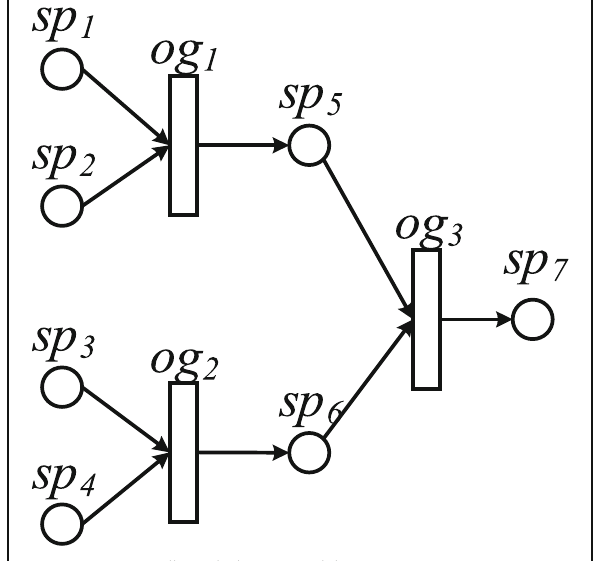
Fig. 10 Dynamically scaled COP model